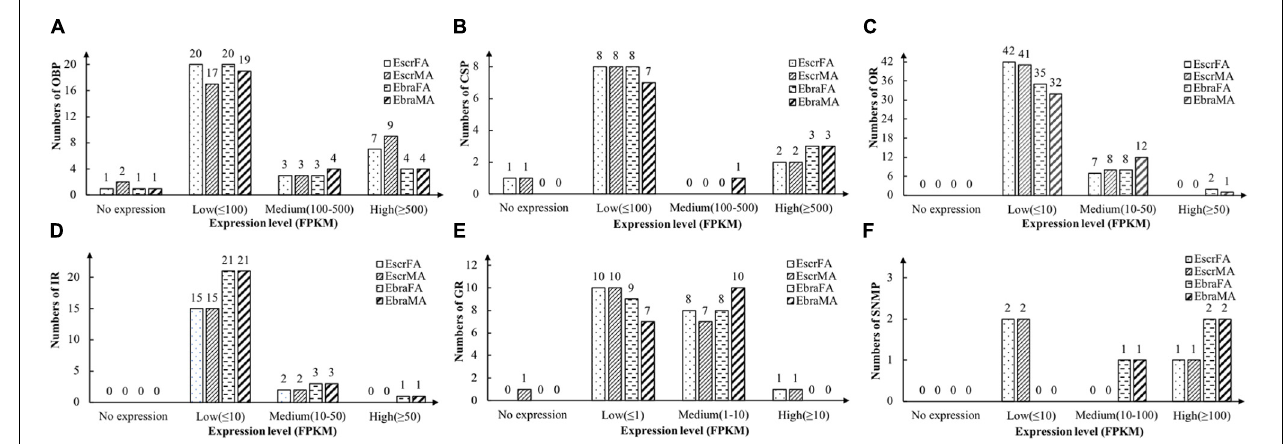
FIGURE 1 | Number of chemosensory genes at different expression levels in female and male antennae of E. scrobiculatus and E. brandti . Expression level is expressed as fragments per kilobase per million mapped fragments (FPKM). (A) OBP; (B) CSP; (C) OR; (D) IR; (E) GR; (F) SNMP.